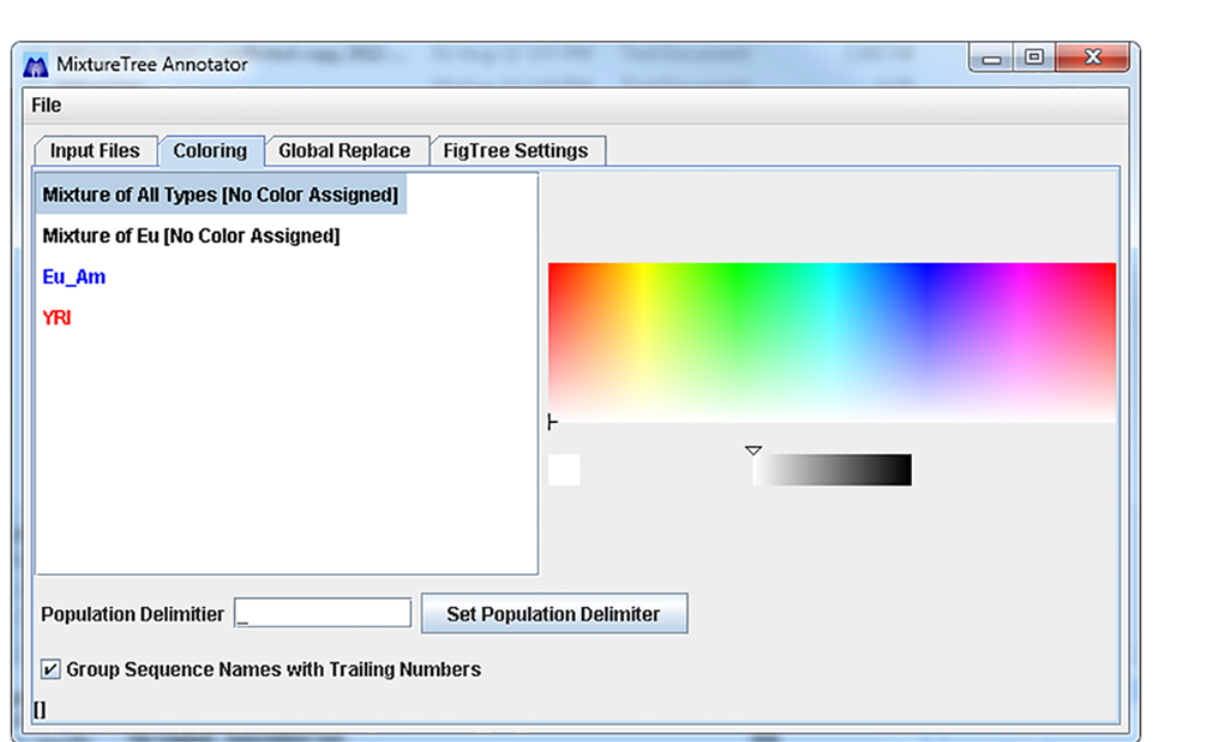
Fig 2. Default Coloring Page of MixtureTree Annotator.